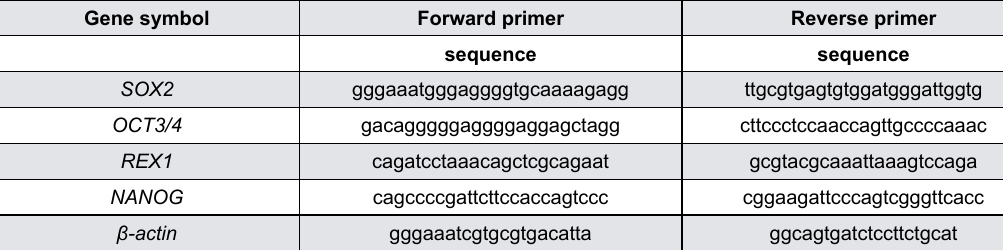
Figure 1- Primers used for PCR